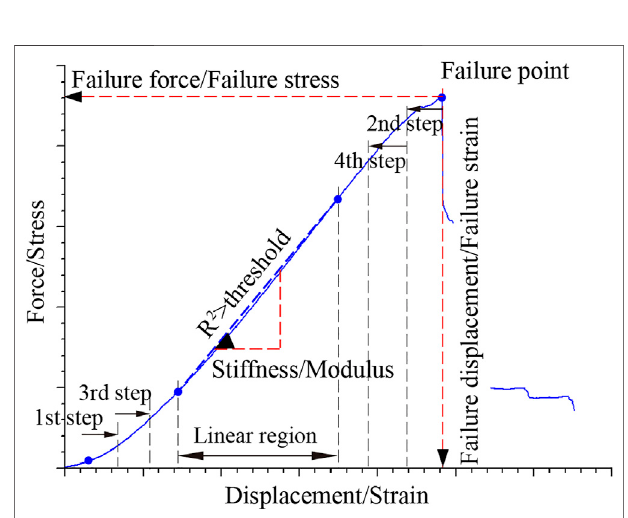
FIGURE 3 | A typical tensile curve of MCL. The maximum force/stress point was de fi ned as the failure point, and the corresponding abscissa and ordinate were the failure displacement/failure strain and failure force/failure stress, respectively. R 2 is the coef fi cient of determination of linear regression. Gradually reduce the number of data points for linear regression. Once R 2 was greater than a threshold (e.g., 0.99), the data segment used for this linear regression was de fi ned as the linear region. The slope of the linear region was the stiffness/modulus.